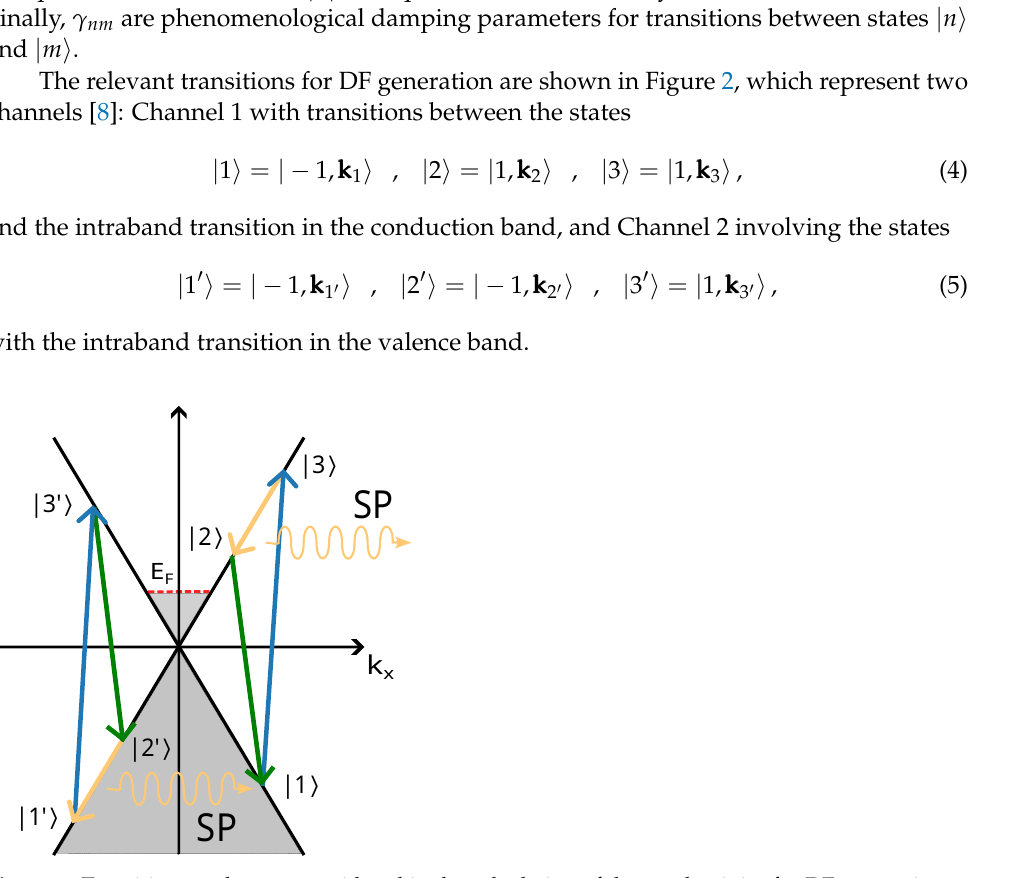
Figure 2. Transitions and states considered in the calculation of the conductivity for DF generation at frequency ω : Channel 1 (right) and Channel 2 (left). For the process of generation of probe photons ( ω a ), the green and yellow arrows are